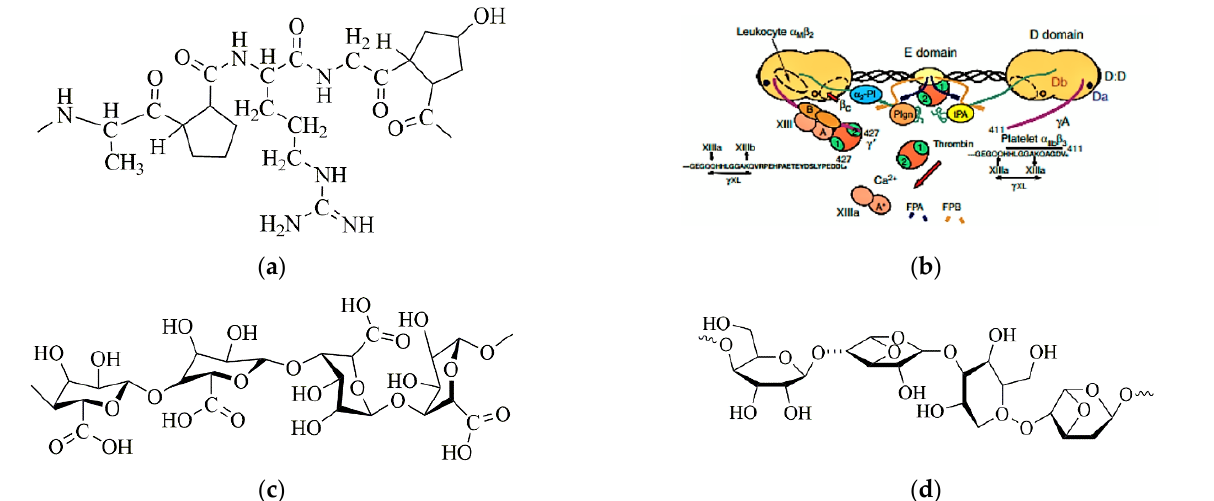
Figure 1. Molecular structures of several nature polymers: ( a ) gelatin; ( b ) fibrinogen; ( c ) alginate; ( d ) agarose.